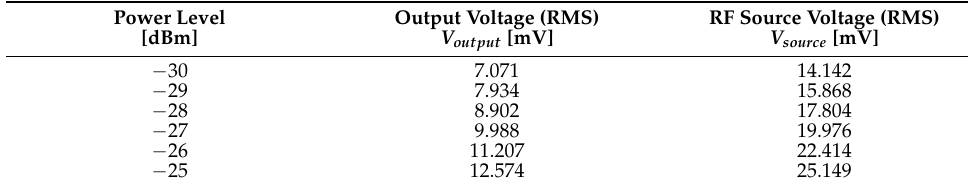
Table A1. Output power and corresponding voltages for a 50 Ω system.